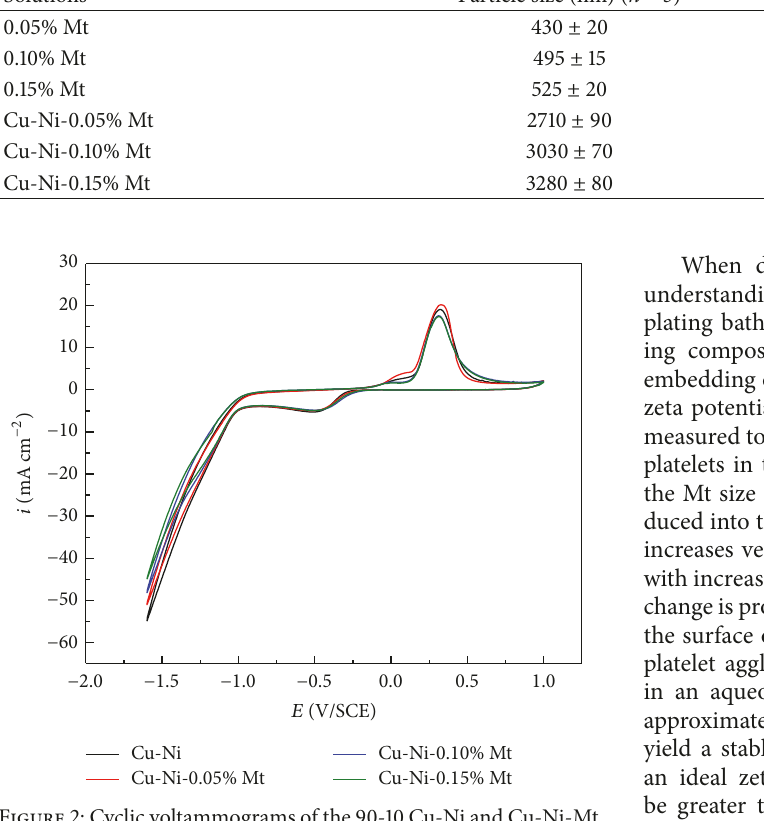
Figure 2: Cyclic voltammograms of the 90-10 Cu-Ni and Cu-Ni-Mt plating solutions, run at a scan rate of 50